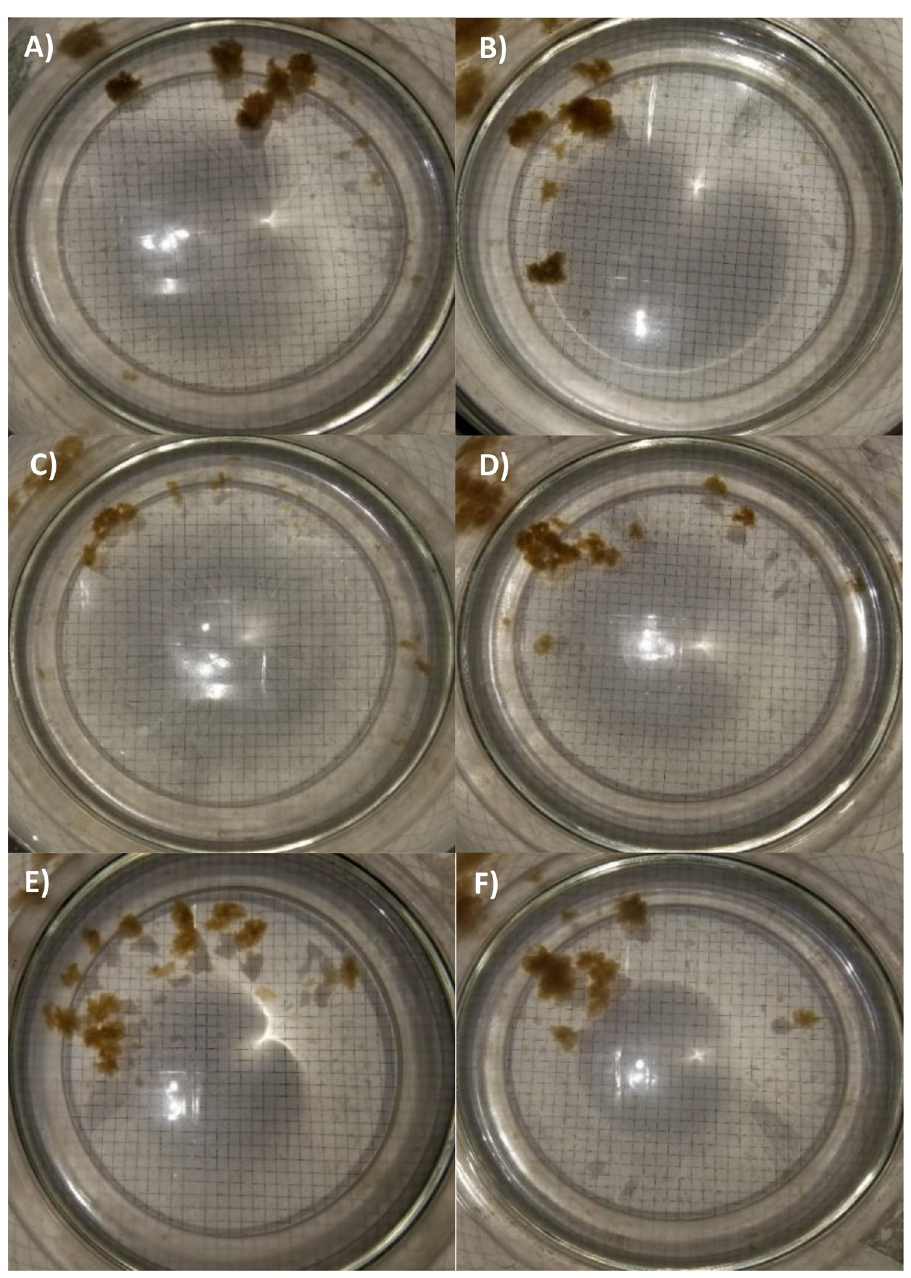
Fig 1. Photographs of marine snow formed by T . pseudonana in each treatment: (A) Control, (B) OA, (C) WAF, (D) OAWAF, (E) DCEWAF and (F) OADCEWAF. Grid squares 0.5 cm by 0.5 cm.